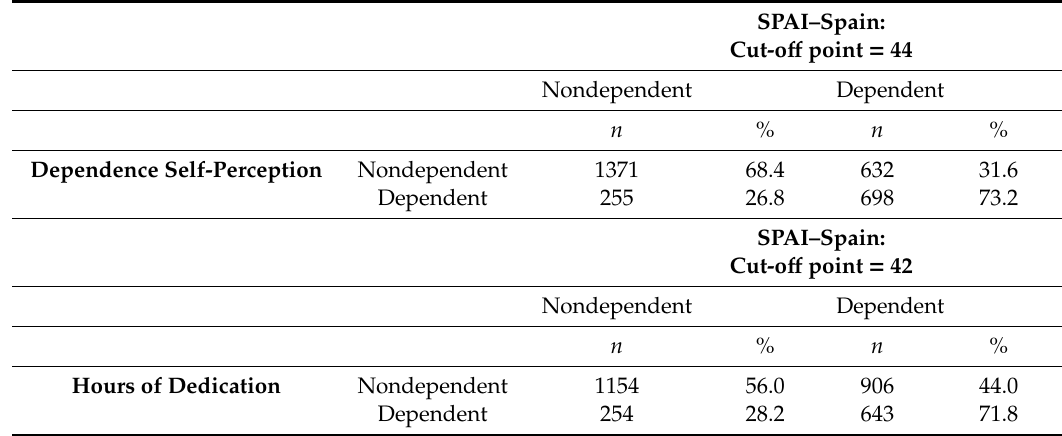
Table 2. Participant’s classification according to their addiction level for the cutoff point for each criterion variable.